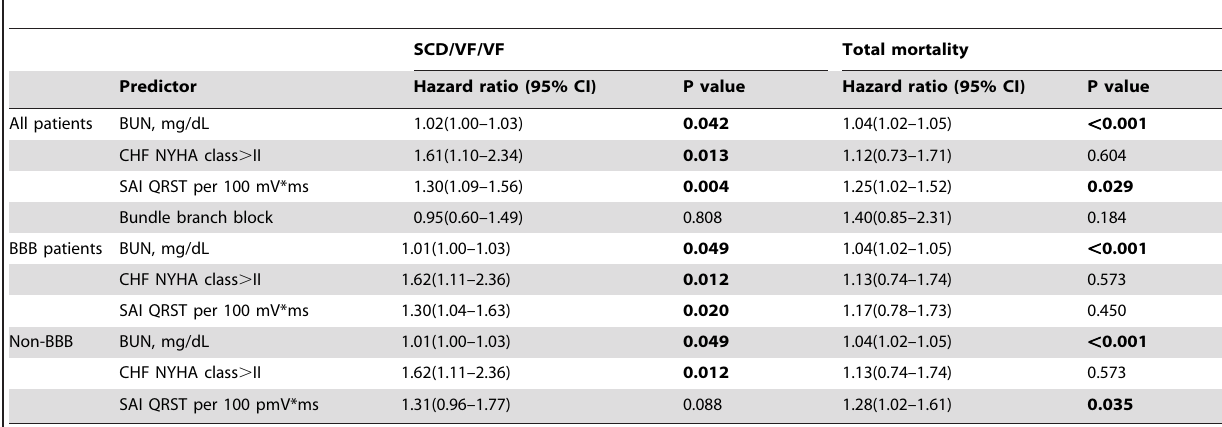
Table 4. Multivariate Cox regression models for prediction of sudden arrhythmic death and all-cause mortality with SAI QRST as continuous variable in patients with and without bundle branch